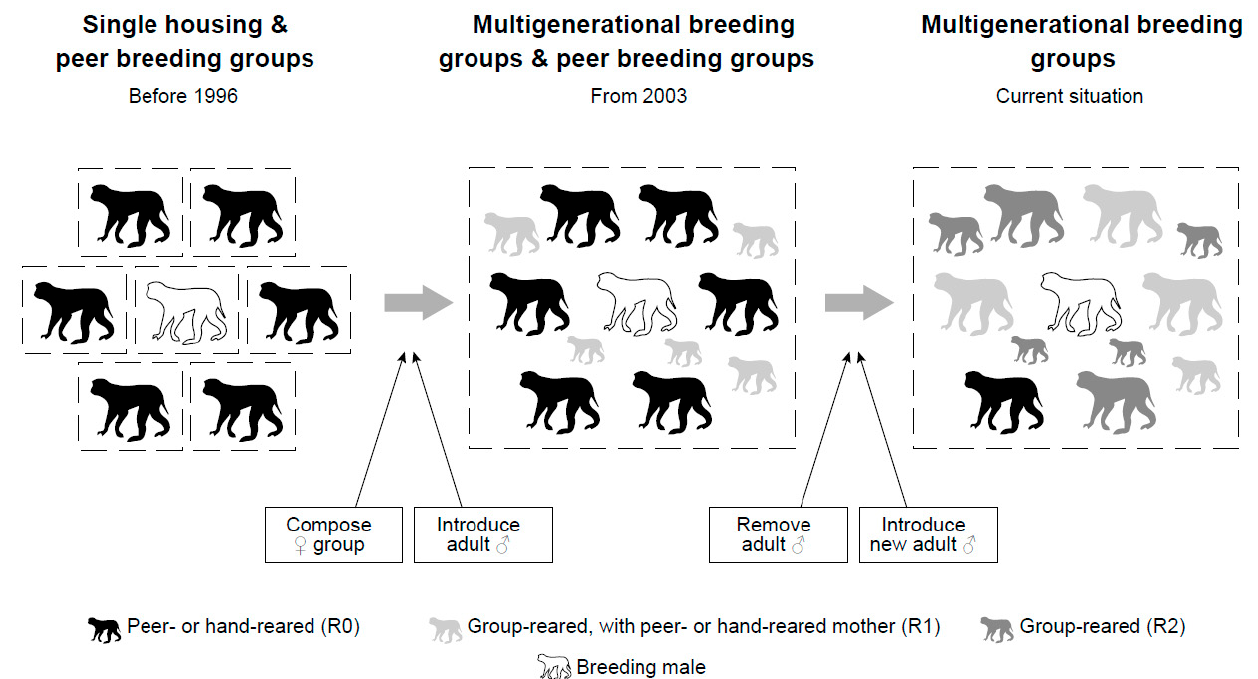
Figure 1. Transition of the different types of housing conditions in which rhesus macaques were previously (<1996) and are currently kept in the BPRC (Rijswijk, The Netherlands). After 1996, the breeding groups consisted of multigenerational groups with varying rearing history (black: peer- or hand-reared (R0); light gray (R1): group-reared, with peer- or hand-reared mother; dark gray: group-reared (R2); white: breeding male).